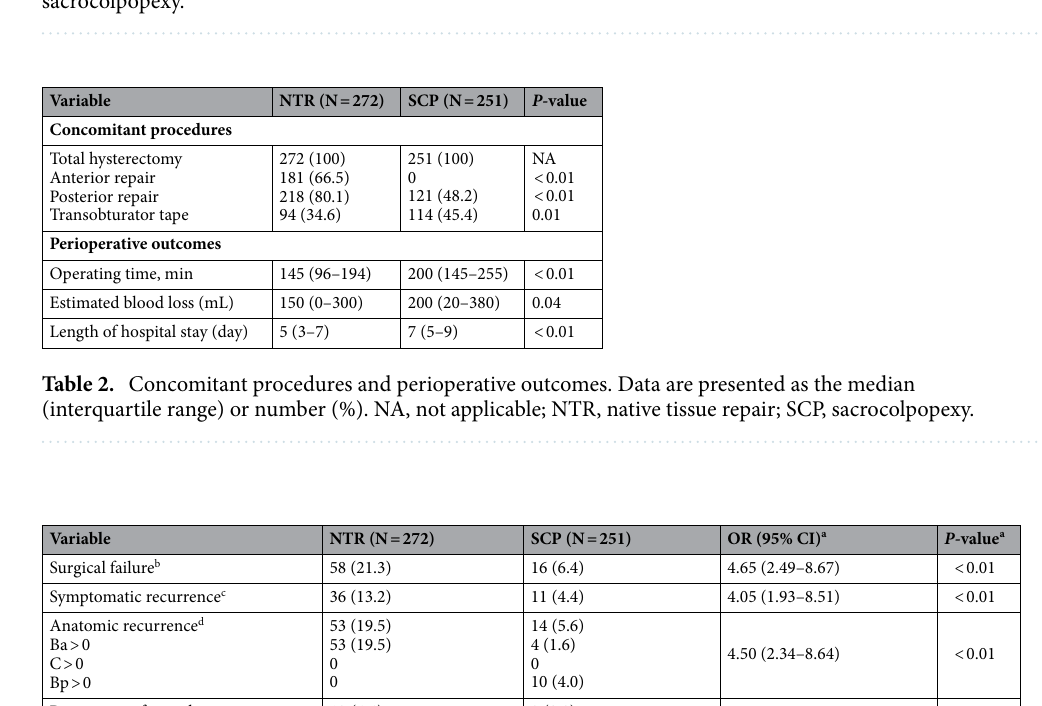
Table 1. Baseline characteristics of the study population. Data are presented as the median (interquartile range) or number (%). NTR, native tissue repair; POPQ, pelvic organ prolapse quantification; SCP, sacrocolpopexy.